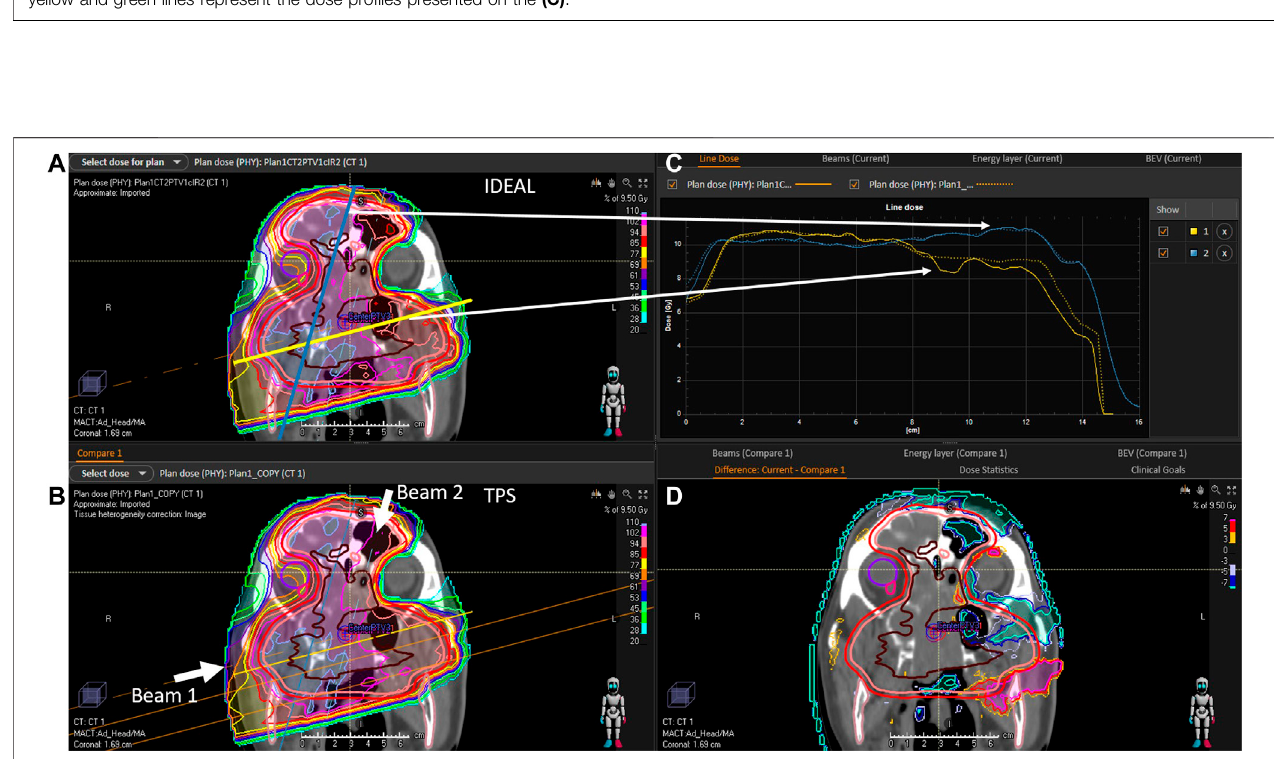
FIGURE6| C1evaluation (A) :2DIDEALdosedistributioninaCTslice(coronalview), (B) :2DTPSdosedistributioninaCTslice(coronalview), (C) :1Ddosepro fi les extractedfromthe2DIDEALandTPSdosedistributionspresented onthe (A,B) (fullline (cid:1) IDEAL,dottedline (cid:1) TPS), (D) :2Ddosedifference inaCTsliceextracted from the 2D IDEAL and TPS dose distributions presented on the (A,B) (IDEAL — TPS). Beam directions are represented on the (B) picture. On the (A) blue and yellow lines represent the dose pro fi les presented on the (C) .